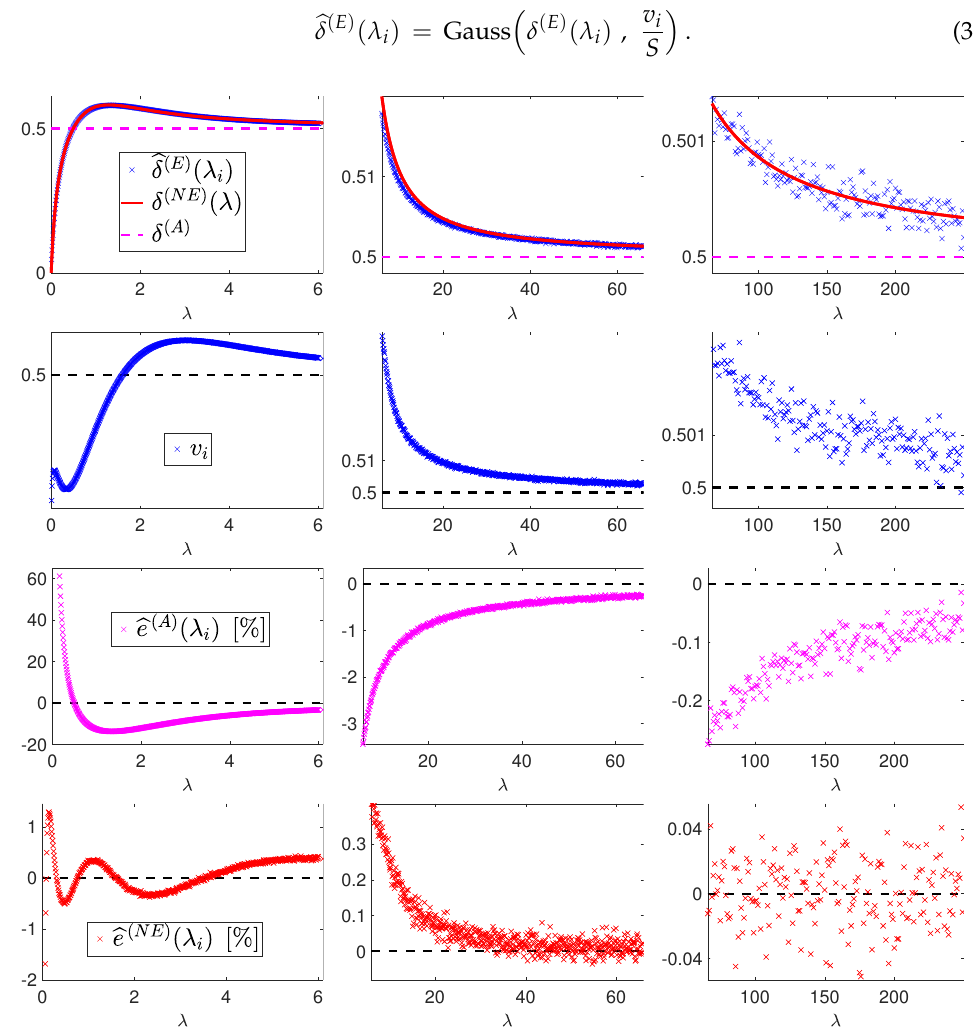
Figure 4. Results of Monte Carlo simulation and weighted least-squares fitting for λ ∈ [ 0,6 ] ( first col- umn), λ ∈ [ 6,66 ] ( second column), and λ ∈ [ 66,250 ] ( third